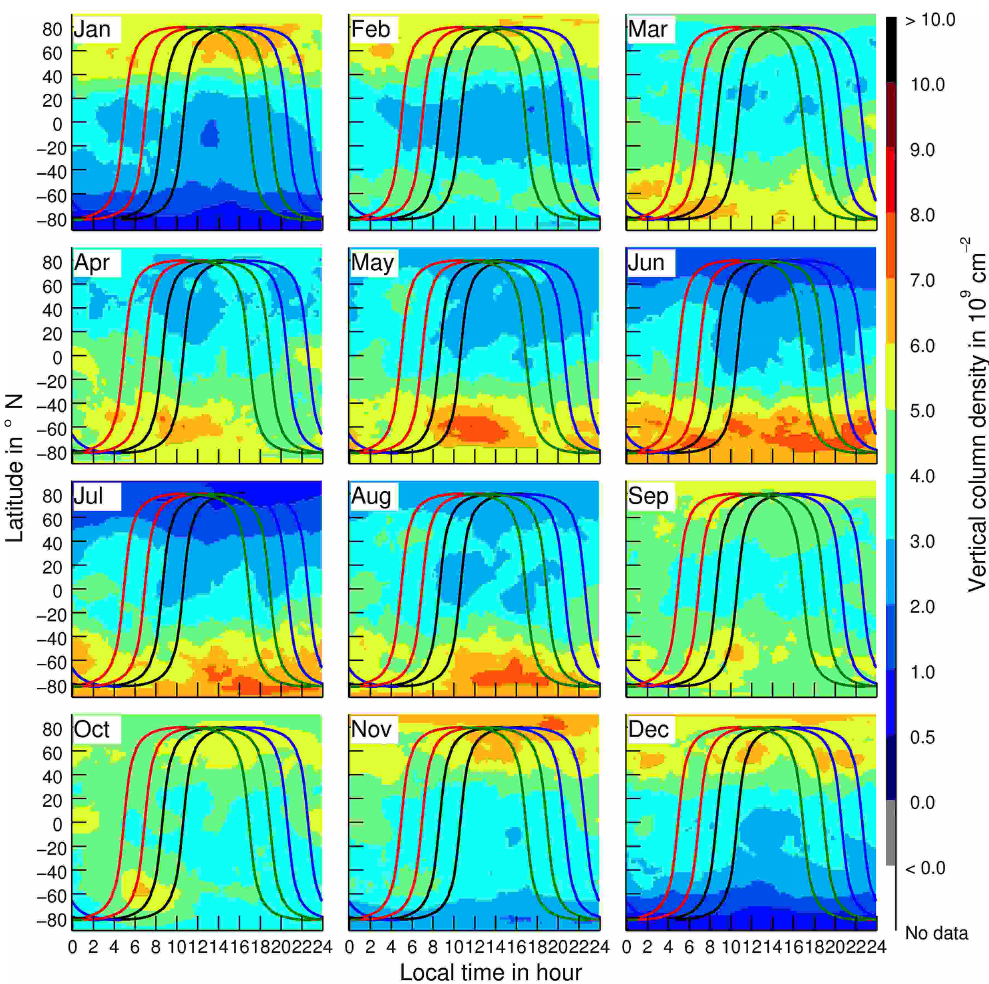
Figure 1. WACCM vertical column densities of multi-annual monthly means during 2008–2012 for different LTs and latitudes. The WACCM data are colocated by only using the data within ± 1h of the satellites LT. The boundaries of the colocation area are indicated by the blue lines for the ascending leg of GOMOS, by the red lines for the descending leg of OSIRIS, by the green lines for the ascending leg of OSIRIS and by the black lines for the SCIAMACHY dayglow measurements as well as for the GOMOS descending